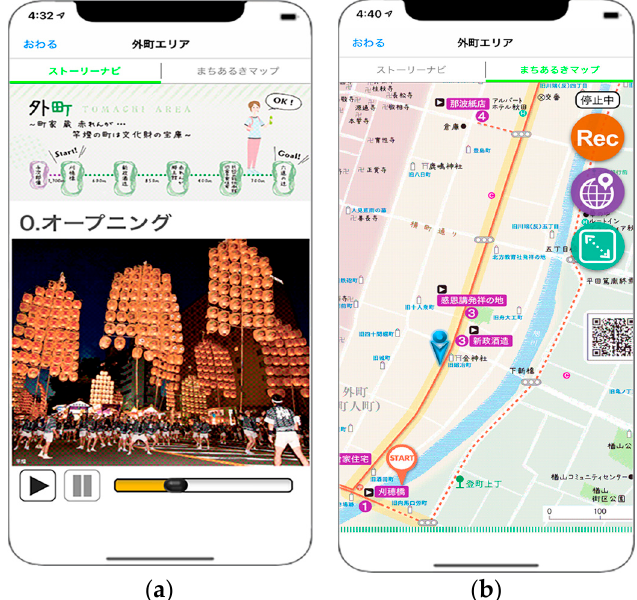
Figure 1. Example displays of our mobile application during walking tours: ( a ) guide content is automatically displayed based on the user’s current location, and ( b ) users can find where they are on the illustrated maps.